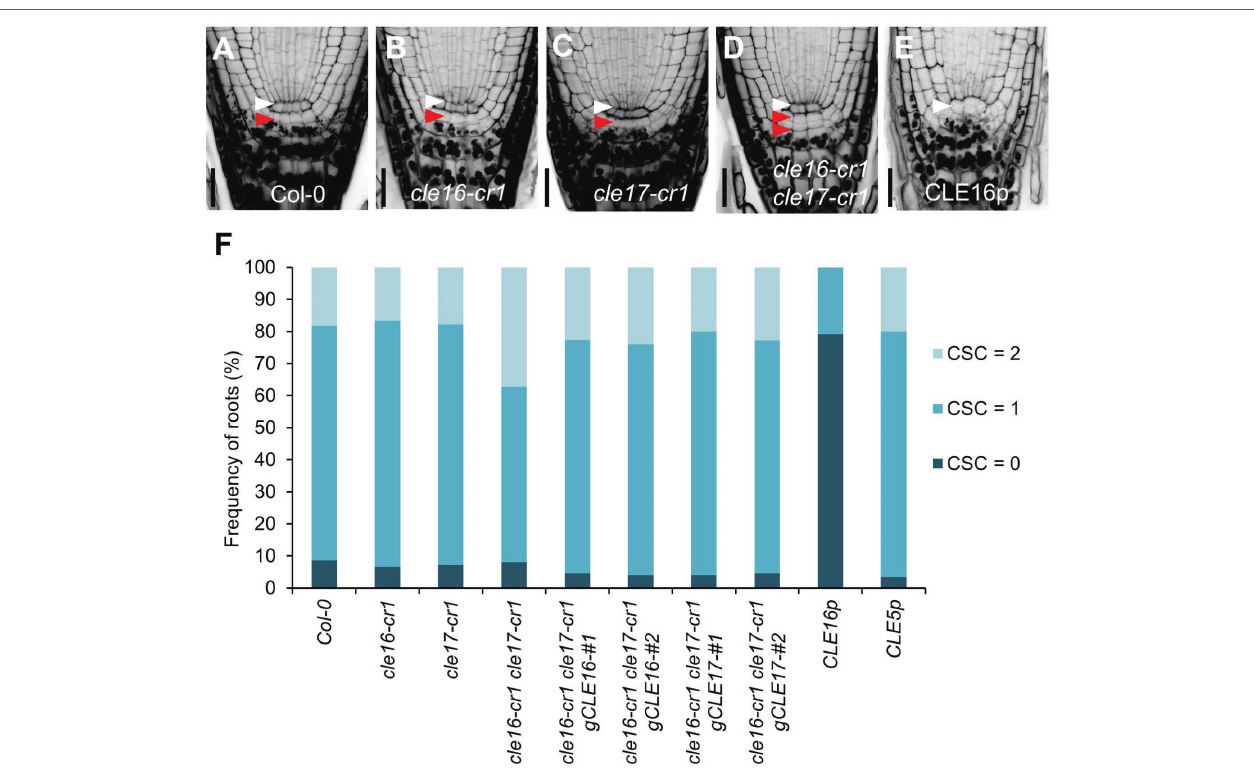
FIGURE 2 | CLE16 / 17 promote columella stem cell (CSC) differentiation. (A–E) Representative confocal images of the root tips at 5 dpg stained with mPS-PI in Col-0 (A) , cle16-cr1 (B) , cle17-cr1 (C) , cle16-cr1 cle17-cr1 (D) , and 5 dpg Col-0 grown on agar medium with 1 μ M CLE16 peptides (CLE16p). White and red arrowheads indicate the QC cells and CSCs, respectively. Scale bars represent 25 μ m. (F) Quantification of CSC differentiation characterized by the accumulation of starch grains (gray or black dots) in the indicated genotypes. Two independent transgenic lines harboring genomic DNA fragment gCLE16 or gCLE17 were analyzed for the complementation test in cle16-cr1 cle17-cr1 double mutants. Roots with differentiated CSCs (0), one layer of CSCs (1), or two layers of CSCs (2) were counted ( n > 50 for each